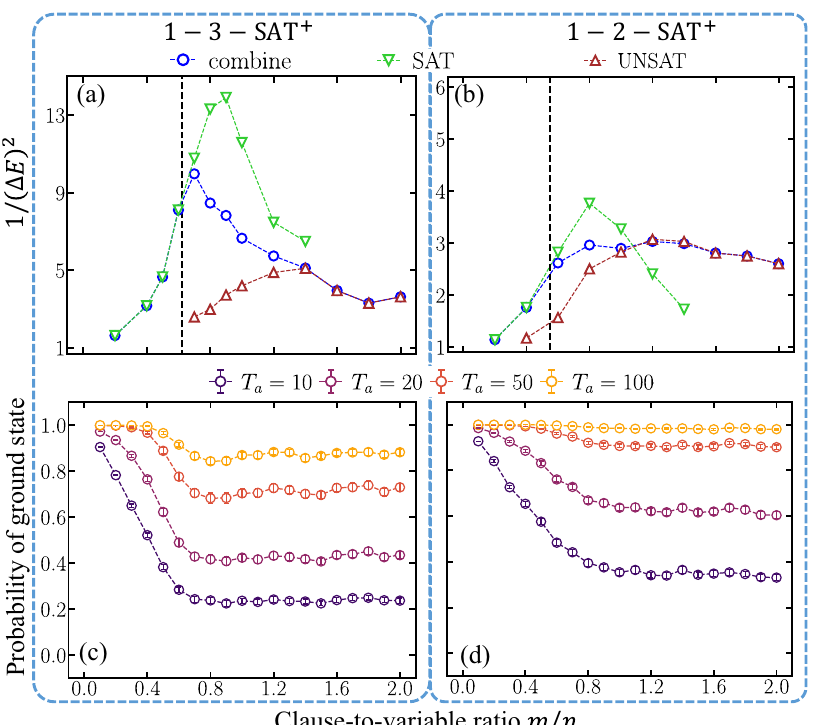
Fig. 7 QAA gap size and performance of 1- k -SAT + . a , b The median of 1/ Δ E 2 of QAA with n = 10 variables shown by blue circles. The green and purple circles represent the SAT and UNSAT instances separately. c , d The probability of the fi nal state after QAA evolution being in the (cid:9) (cid:8) P D ground state, P ¼ j ψ i j ϕ QAA j 2 . All results and error bars are estimated over 100 i ¼ 1